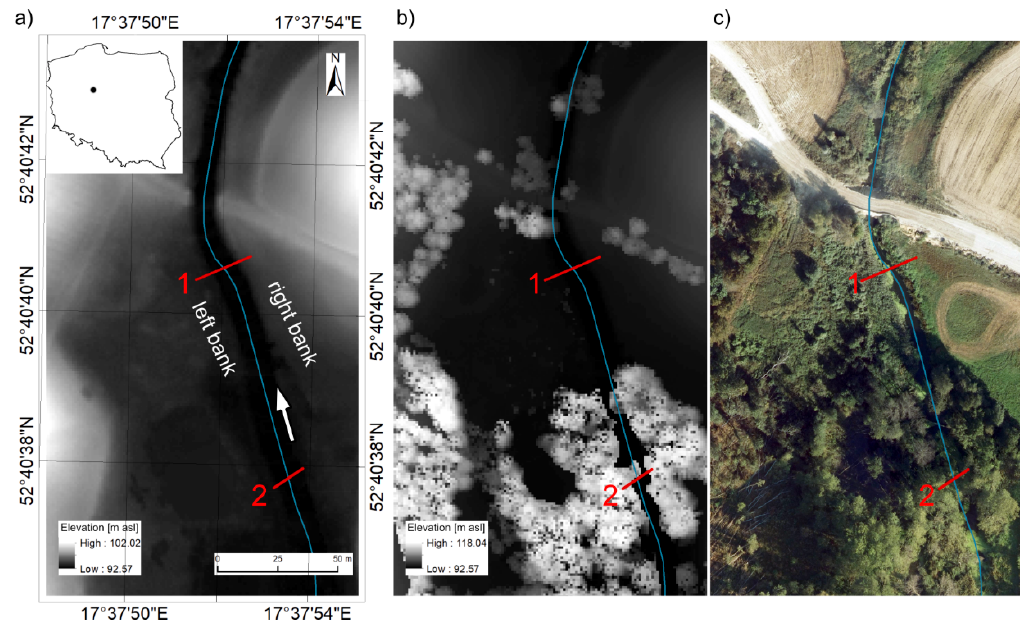
Figure 1. Location of the studied site in: ( a ) the digital elevation model (DEM), ( b ) the digital surface model (DSM), and ( c ) an aerial photograph.